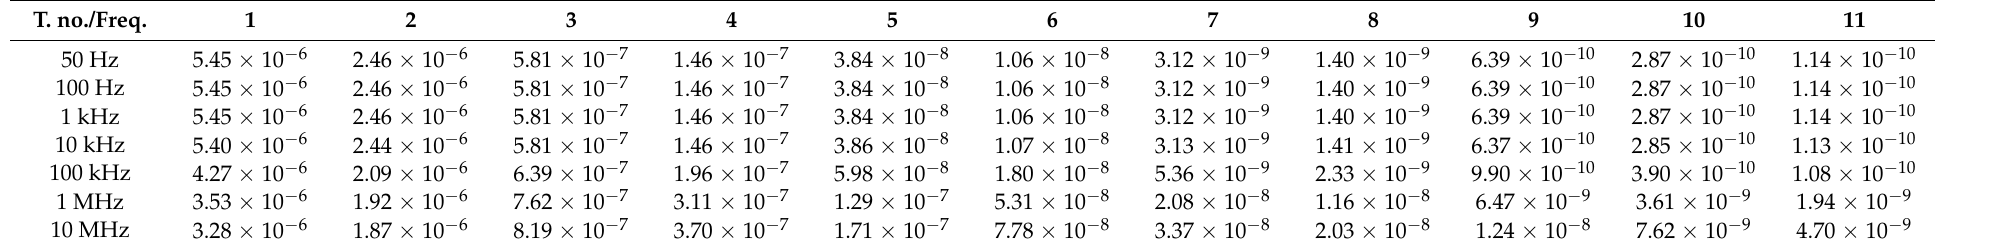
Table 4. Self and mutual inductances of turn 1 (in H) resulting from FEM simulations.